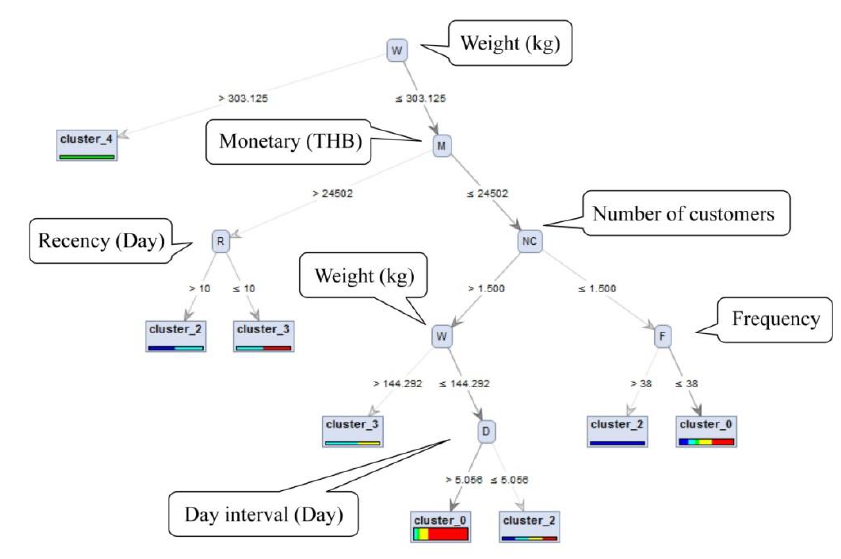
Figure 7. Decision tree model.